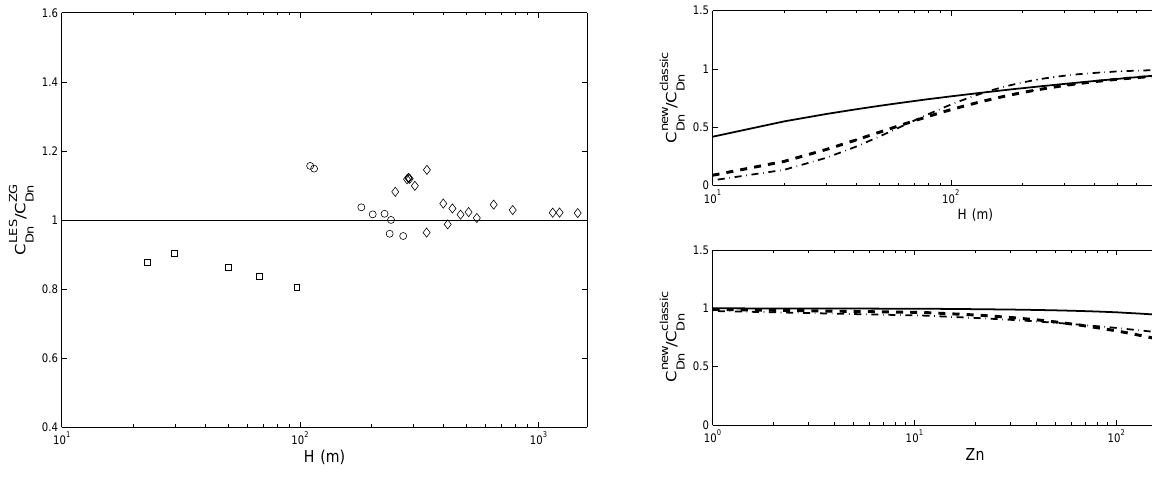
Fig. 12. The dependence of C LES is given by Eq. (25). Symbols and lines are the same as in Fig. 5.